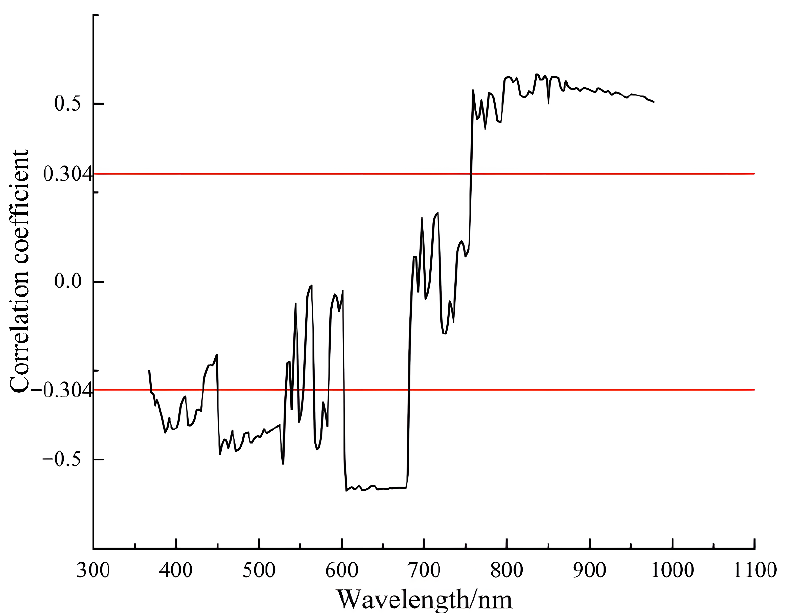
Figure 4. The correlation curves of FD after denoising by EEMD-db3 with the CU content in the fresh state. Note: p ≤ 0.05.